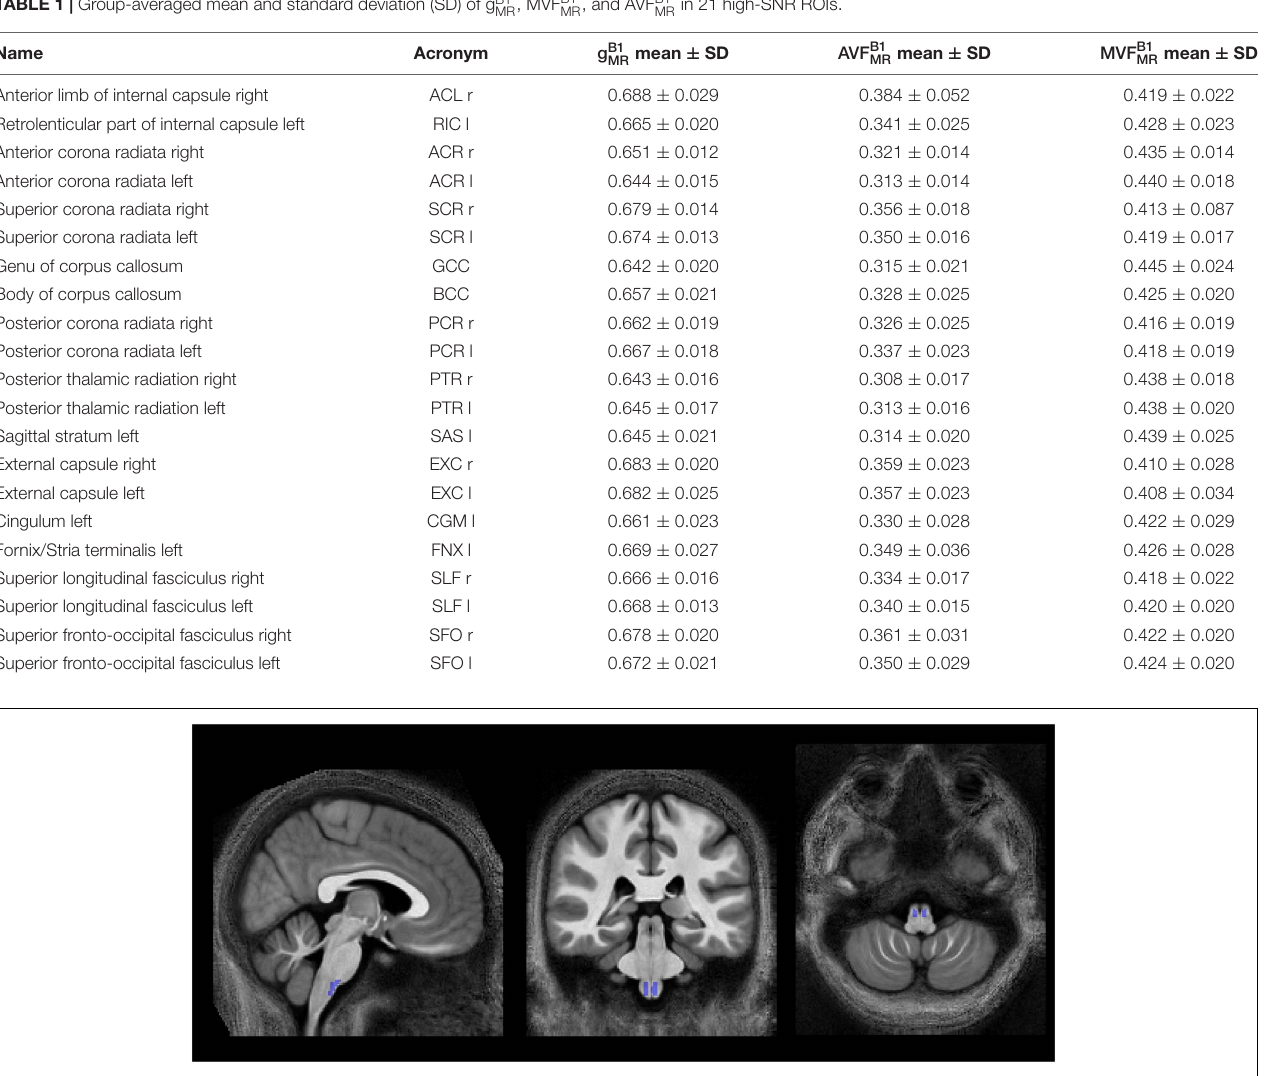
FIGURE 2 | Location of the pyramidal tracts in the medulla oblongata ROI, overlaid on the group-averaged MT B1 sat map, that was used to determine the calibration constant, converting MT sat into MVF MR (section “Computation of MVF MR , AVF MR , and g MR (cid:48)(cid:48) ). To create this ROI, the corticospinal tract ROI of the JHU-ICBM-DTI-81 atlas, which extends across the pons and medulla pyramids, was modified to cover only the medulla pyramids. Left-right position: X = 82; anterior-posterior position: Y = 77; superior-inferior position, Z =